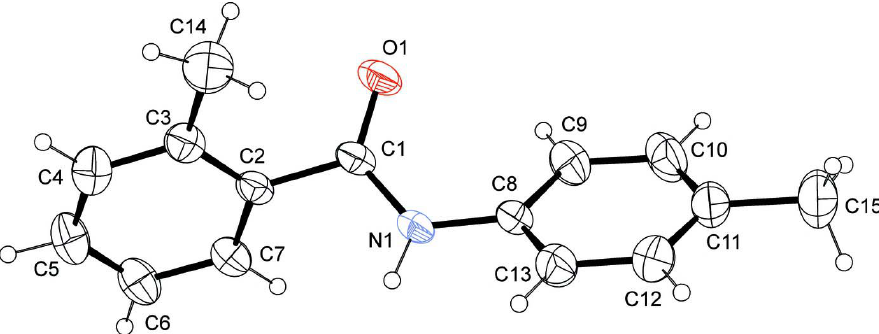
Figure 1 Molecular structure of (I) showing the atom labelling scheme and displacement ellipsoids at the 30% probability